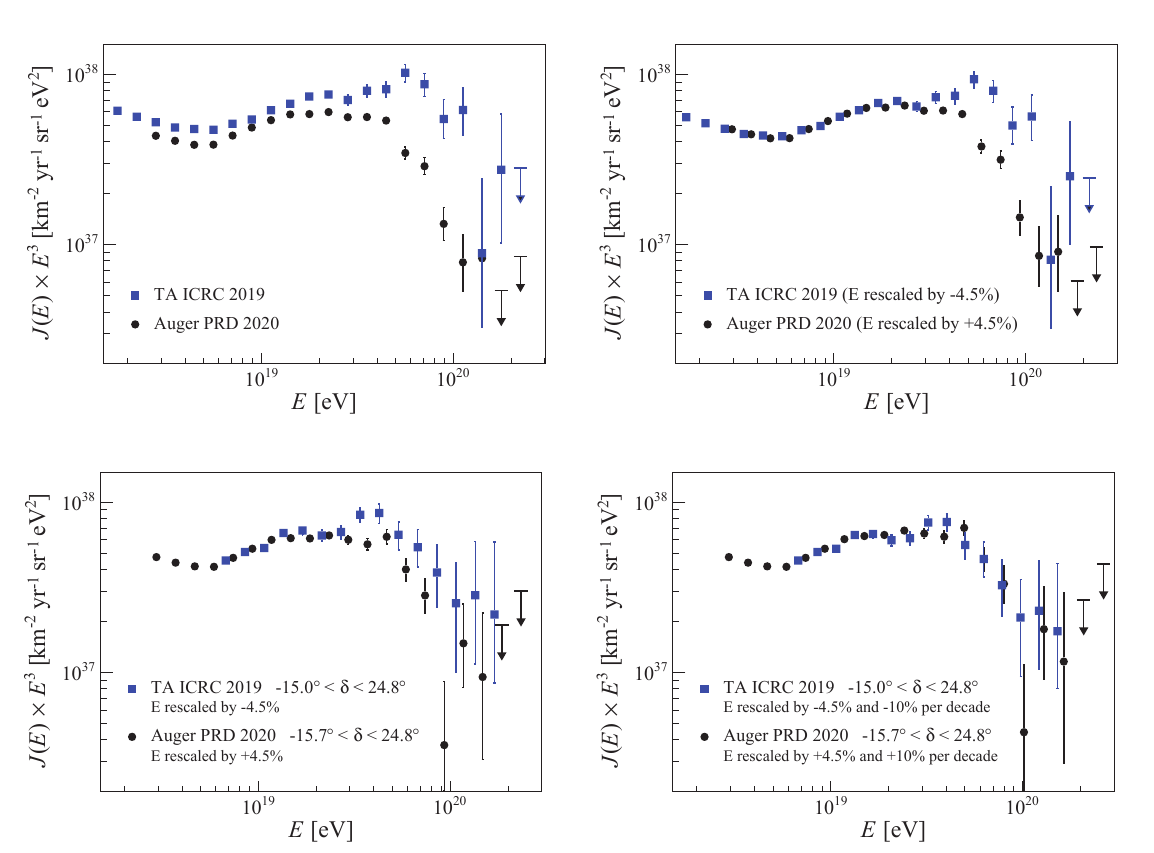
Figure 2. Energy spectrum measured by Auger [7] and TA [9] in the full declination band (upper-left), in the full band after a rescaling of the energy by an overall 9% factor (upper-right), in the common band with the same energy rescaling factor (bottom- left) and in the common band once the energy scale is furtherly rescaled in an energy dependent way by 20% / decade defined as (cid:3) (cid:2) Δ E / E = ± 4 . 5 ± 10log ( E / 10 19 eV) 10